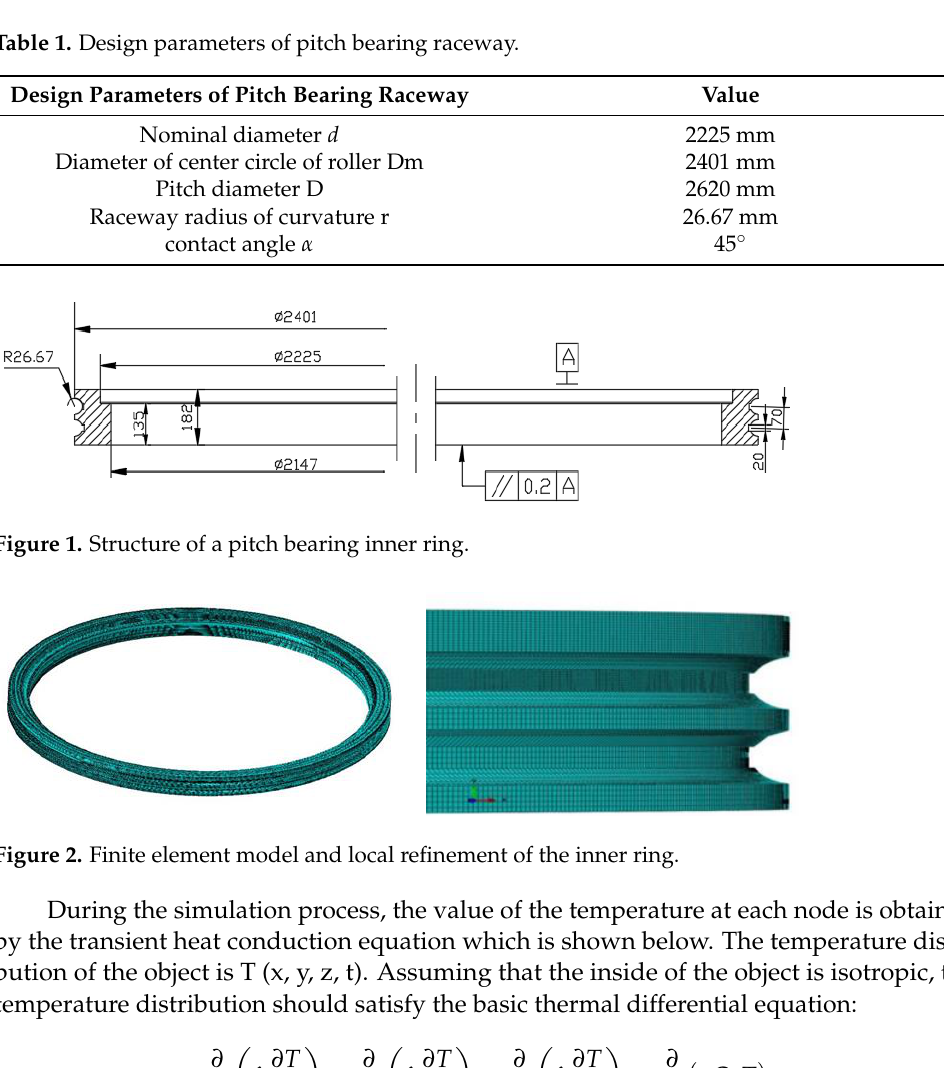
Table 2. Specific heat capacity and thermal conductivity of 42CrMo steel. Temperature T (°C)